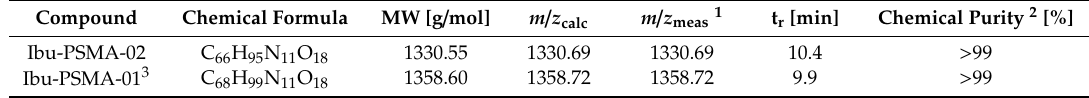
Table 1. Analytical data of Ibu-PSMA-02 and